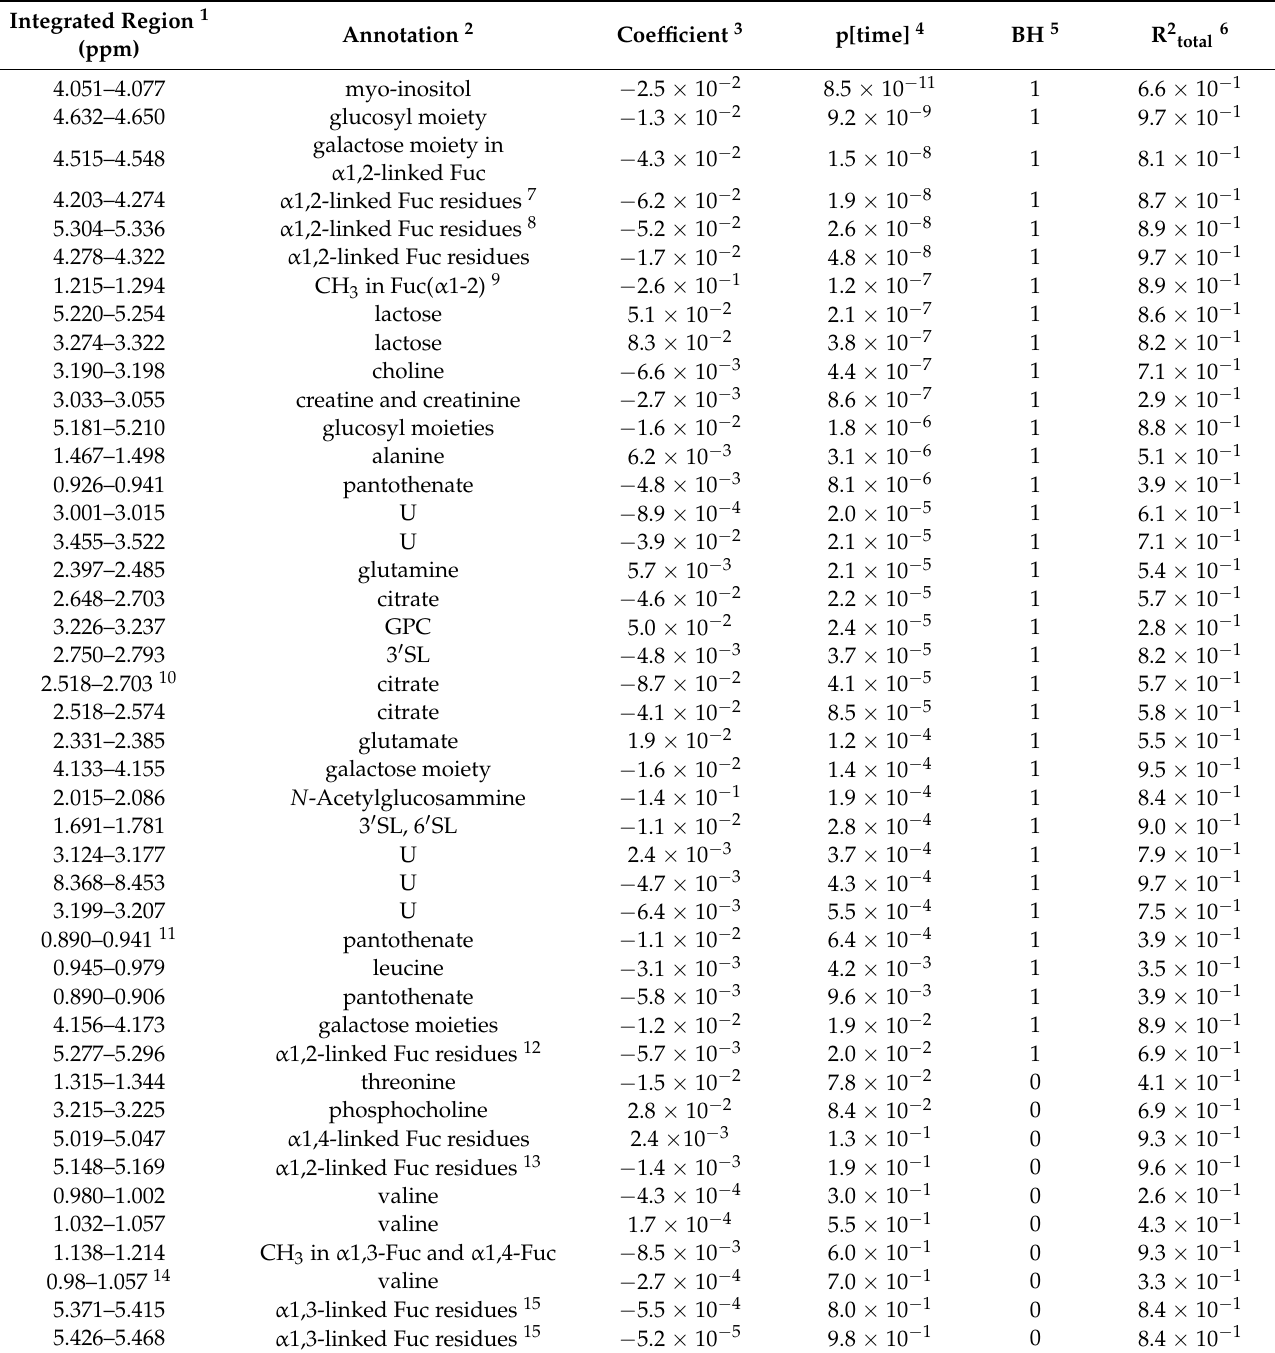
Table 2. LME modelling results for longitudinal data using the 44 features and all the three degrees of